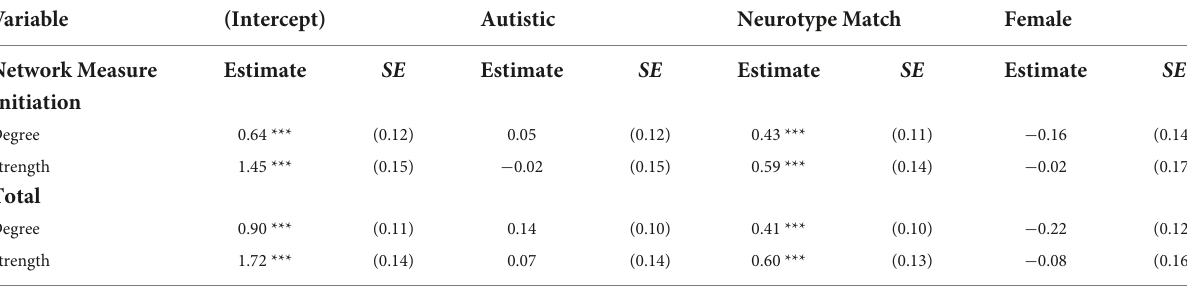
TABLE 3 Effects of neurotype match on node degree and node strength in mixed-effects models.